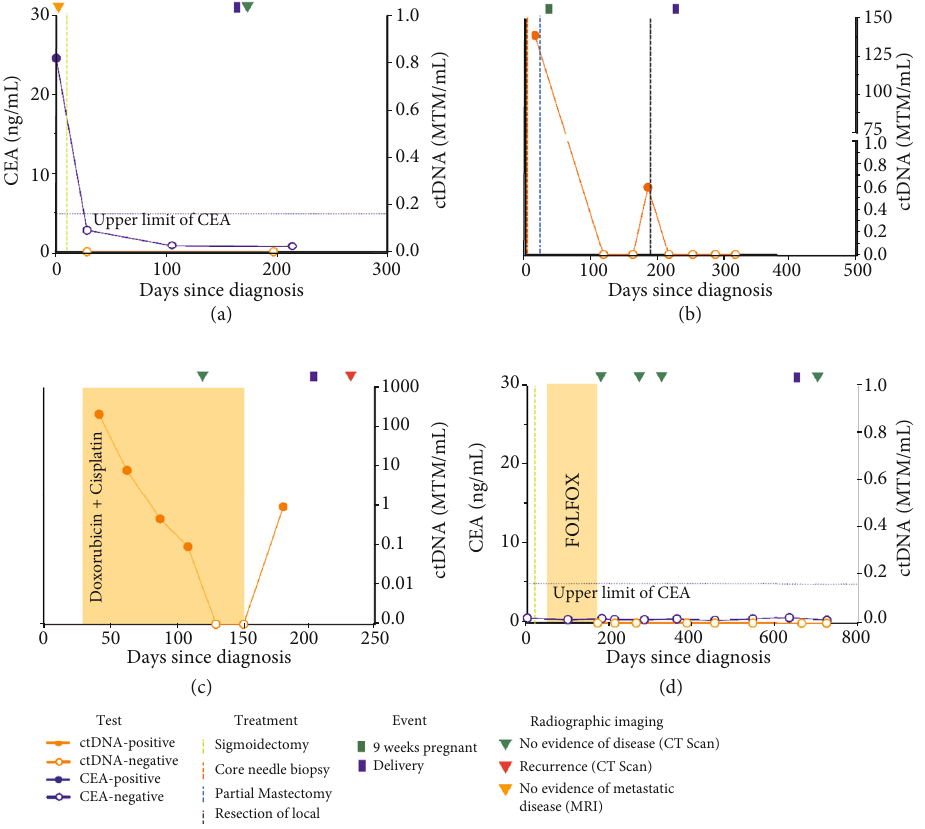
Figure 1: Use of tumor-informed mPCR NGS-based ctDNA testing in pregnant patients. (a – d) Individual patient clinical courses are represented. Circulating tumor DNA; CEA: carcinoembryonic